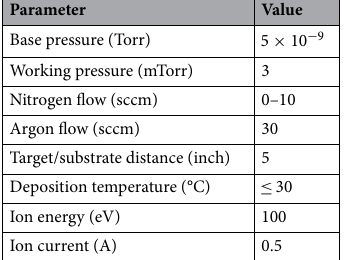
Table 1. TiN sputtering chamber deposition